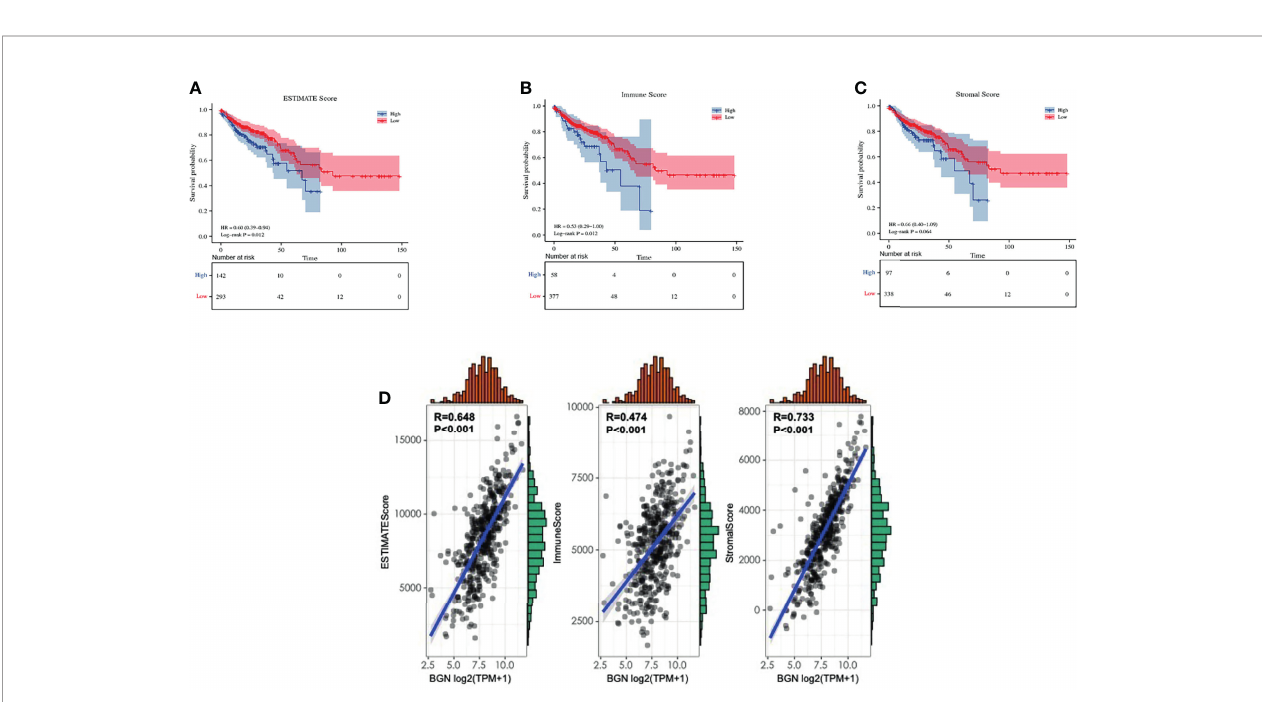
FIGURE 4 | The correlation between BGN expression and tumor microenvironment scores in colon cancer. (A – C) ESTIMATE score, immune score and stromal score in predicting overall survival of colon cancer based on Kaplan-Meier analysis. The signi fi cance was calculated by the Log-rank test. (D) BGN expression is strongly associated with estimate score, immune score and stromal score in colon cancer based on Pearson correlation analysis. p<0.05 was considered statistically signi fi cant. The above analysis were based on TCGA expression